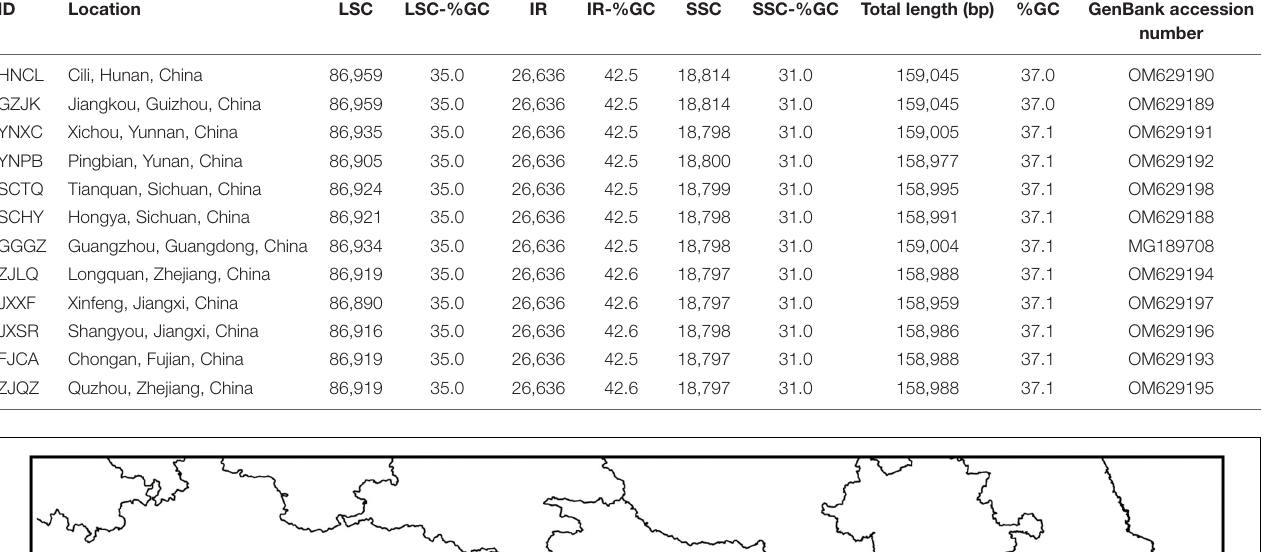
TABLE 1 | Sampling information and chloroplast genome sequences information of B. sinensis .